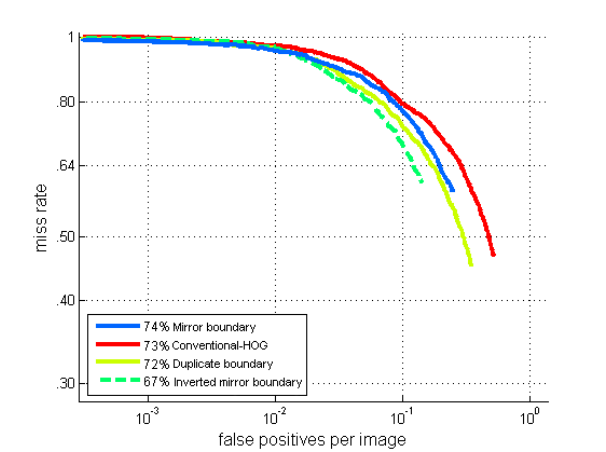
Figure 8. ROC curves of the mix-training-dataset approach with 50% distorted training dataset, using different padding